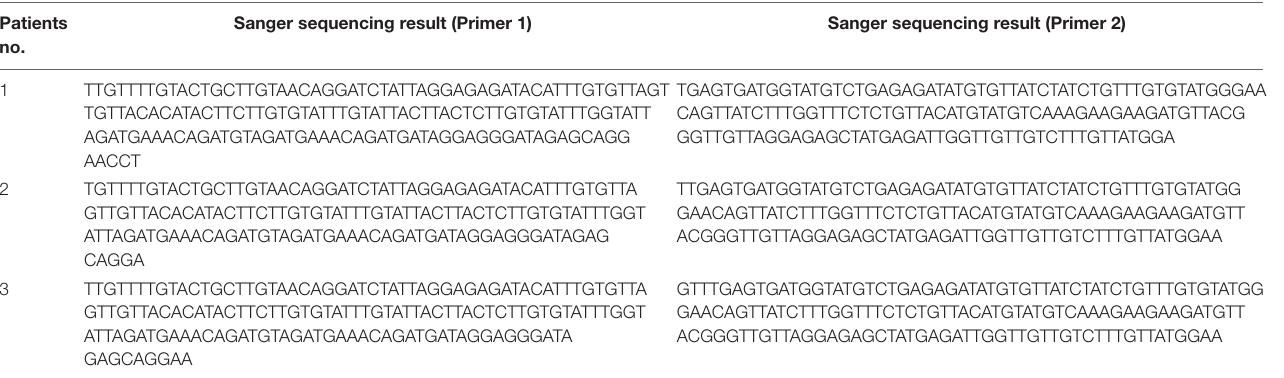
TABLE 2 | The Sanger sequencing result of qPCR product with T. whipplei for each patients. Patients